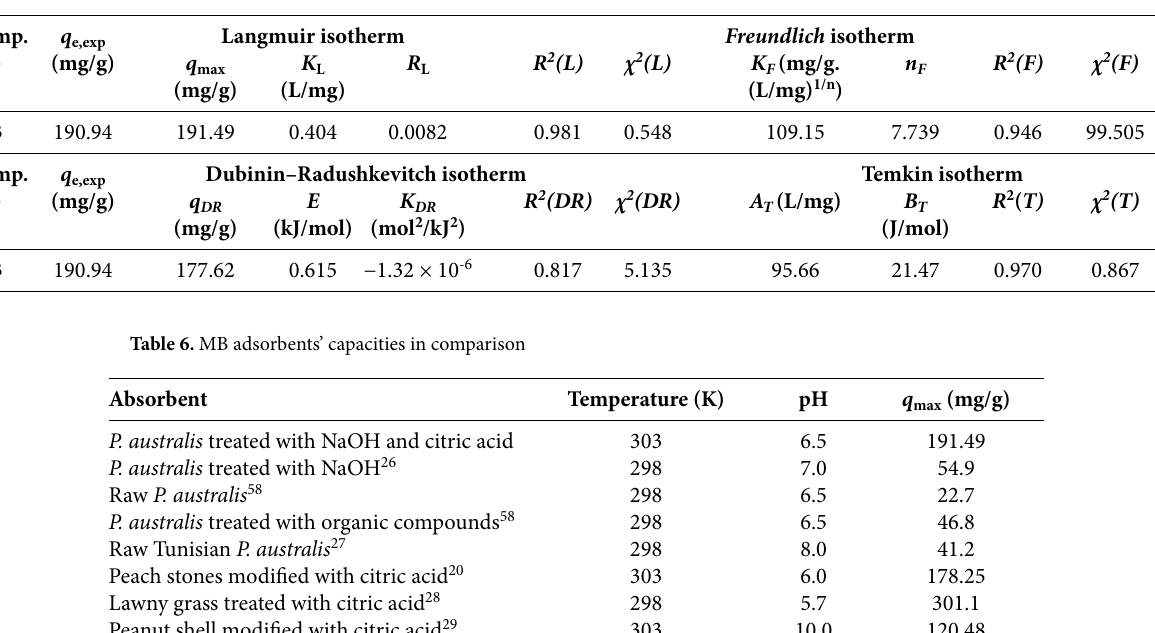
Table 5. Isotherm parameters for MB adsorption by SA-RPB at 303K Temp.